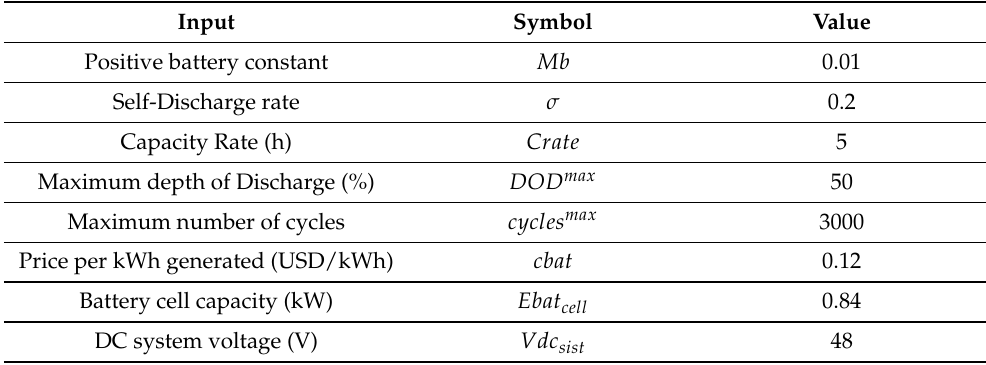
Table 3. Input parameters of the